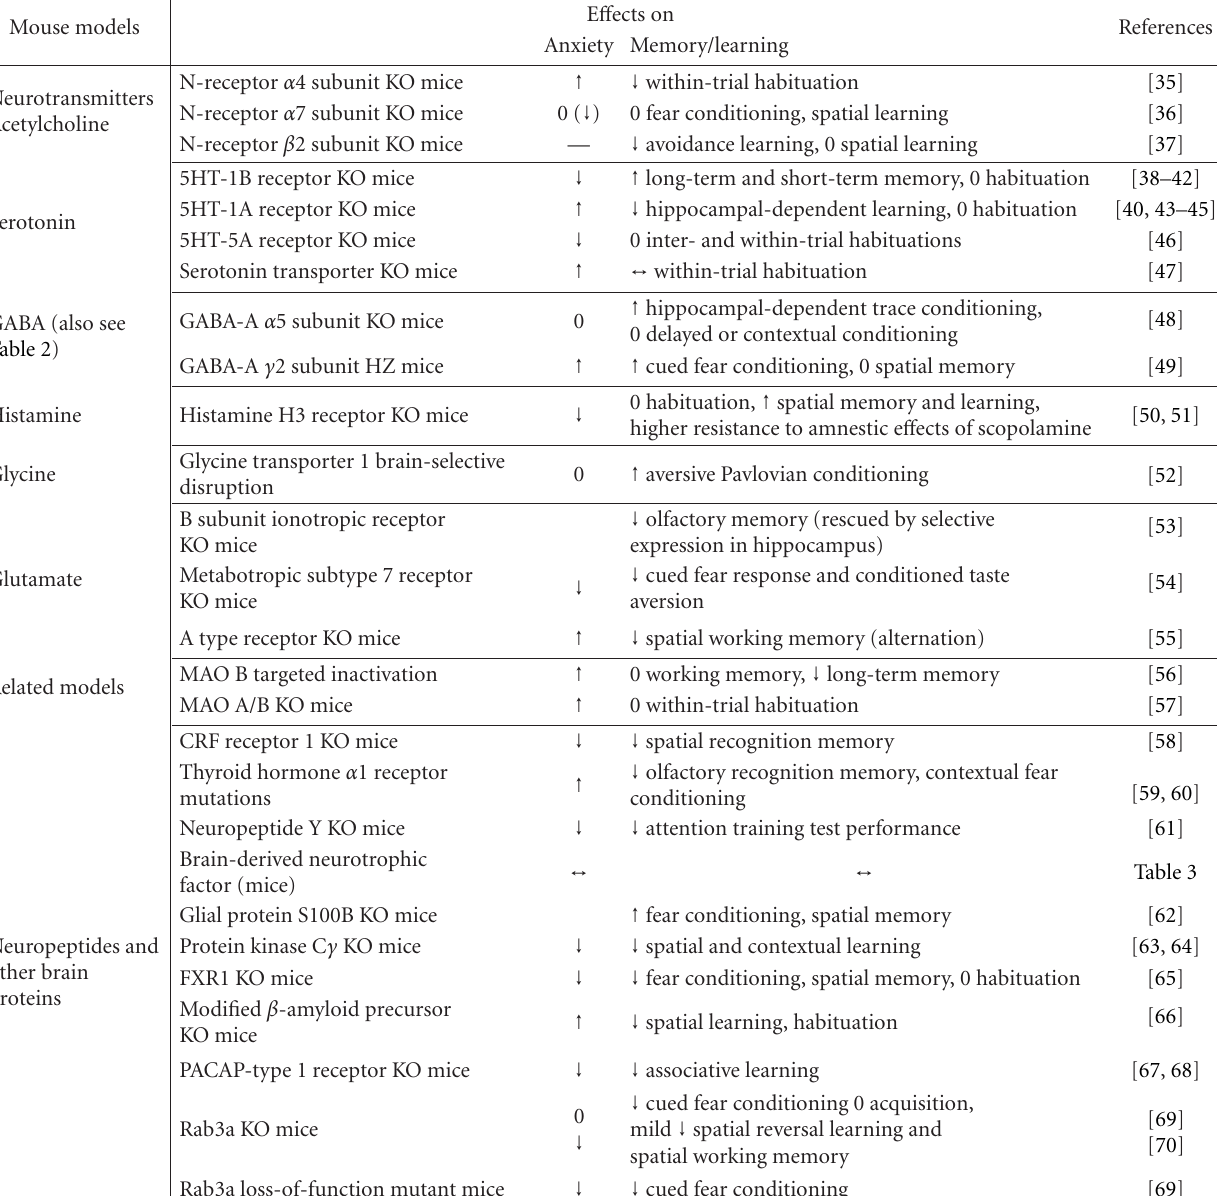
Table 1: Mouse mutagenesis data on memory and anxiety phenotypes [8]; see text for details. KO: knockout ( − / − ), HZ: heterozygous (+ / − ) mice. ( ↑ : increased, ↓ : reduced, 0: no e ff ects, ↔ : mixed or unclear results. CRF: corticotropin-releasing factor, MAO: monoamine oxidase A/B, FXR1: fragile X-related protein 1, PACAP: pituitary adenylate cyclase activating polypeptide, Rab3a: ras -associated binding 3a